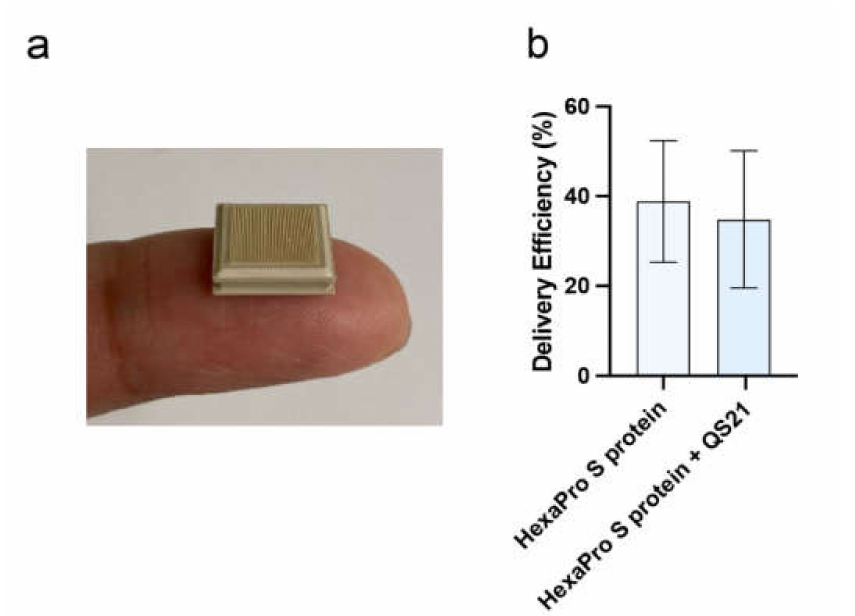
Figure 2. HexaPro S protein-based vaccine and its application using HD-MAP. ( a ) HD-MAPs con- taining 5000 solid polymer microprojection arrays to deliver vaccine into the cutaneous layer of the skin. ( b ) Delivery efficiency of antigen into the skin using HD-MAPs coated with SARS CoV-2 HexaPro S protein and QS-21-adjuvanted SARS CoV-2 HexaPro S protein ( n = 5, each) was measured by comparing the remaining protein from the delivered HD-MAPs to undelivered HD-MAPs using capture